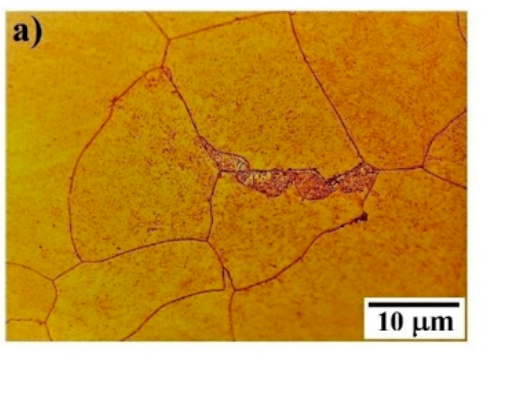
Figure 7. Optical micrographs of AZ91 alloy aged at 200 ◦ C for ( a ) 4 h, ( b ) 24 h, ( c ) 96 h, and ( d ) 192 h.